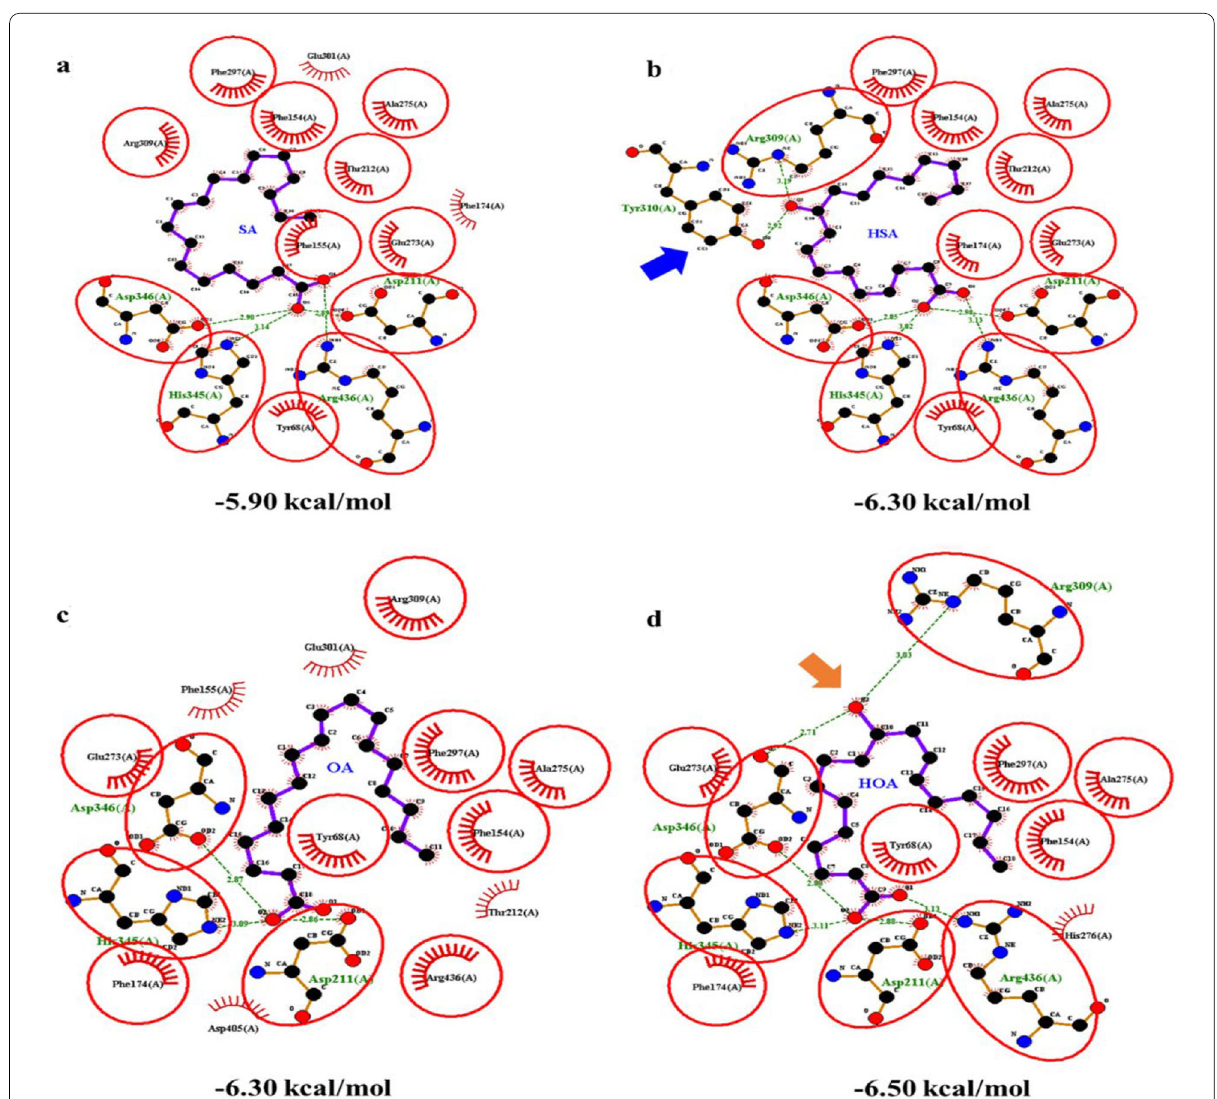
. a SA, b HSA, c OA, d HOA +